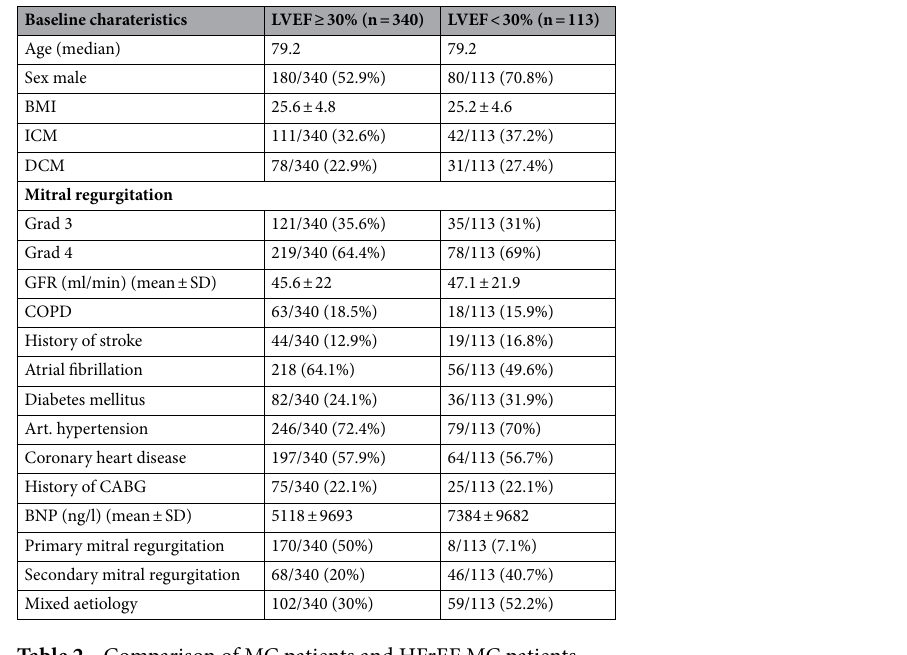
Table 2. Comparison of MC patients and HFrEF MC